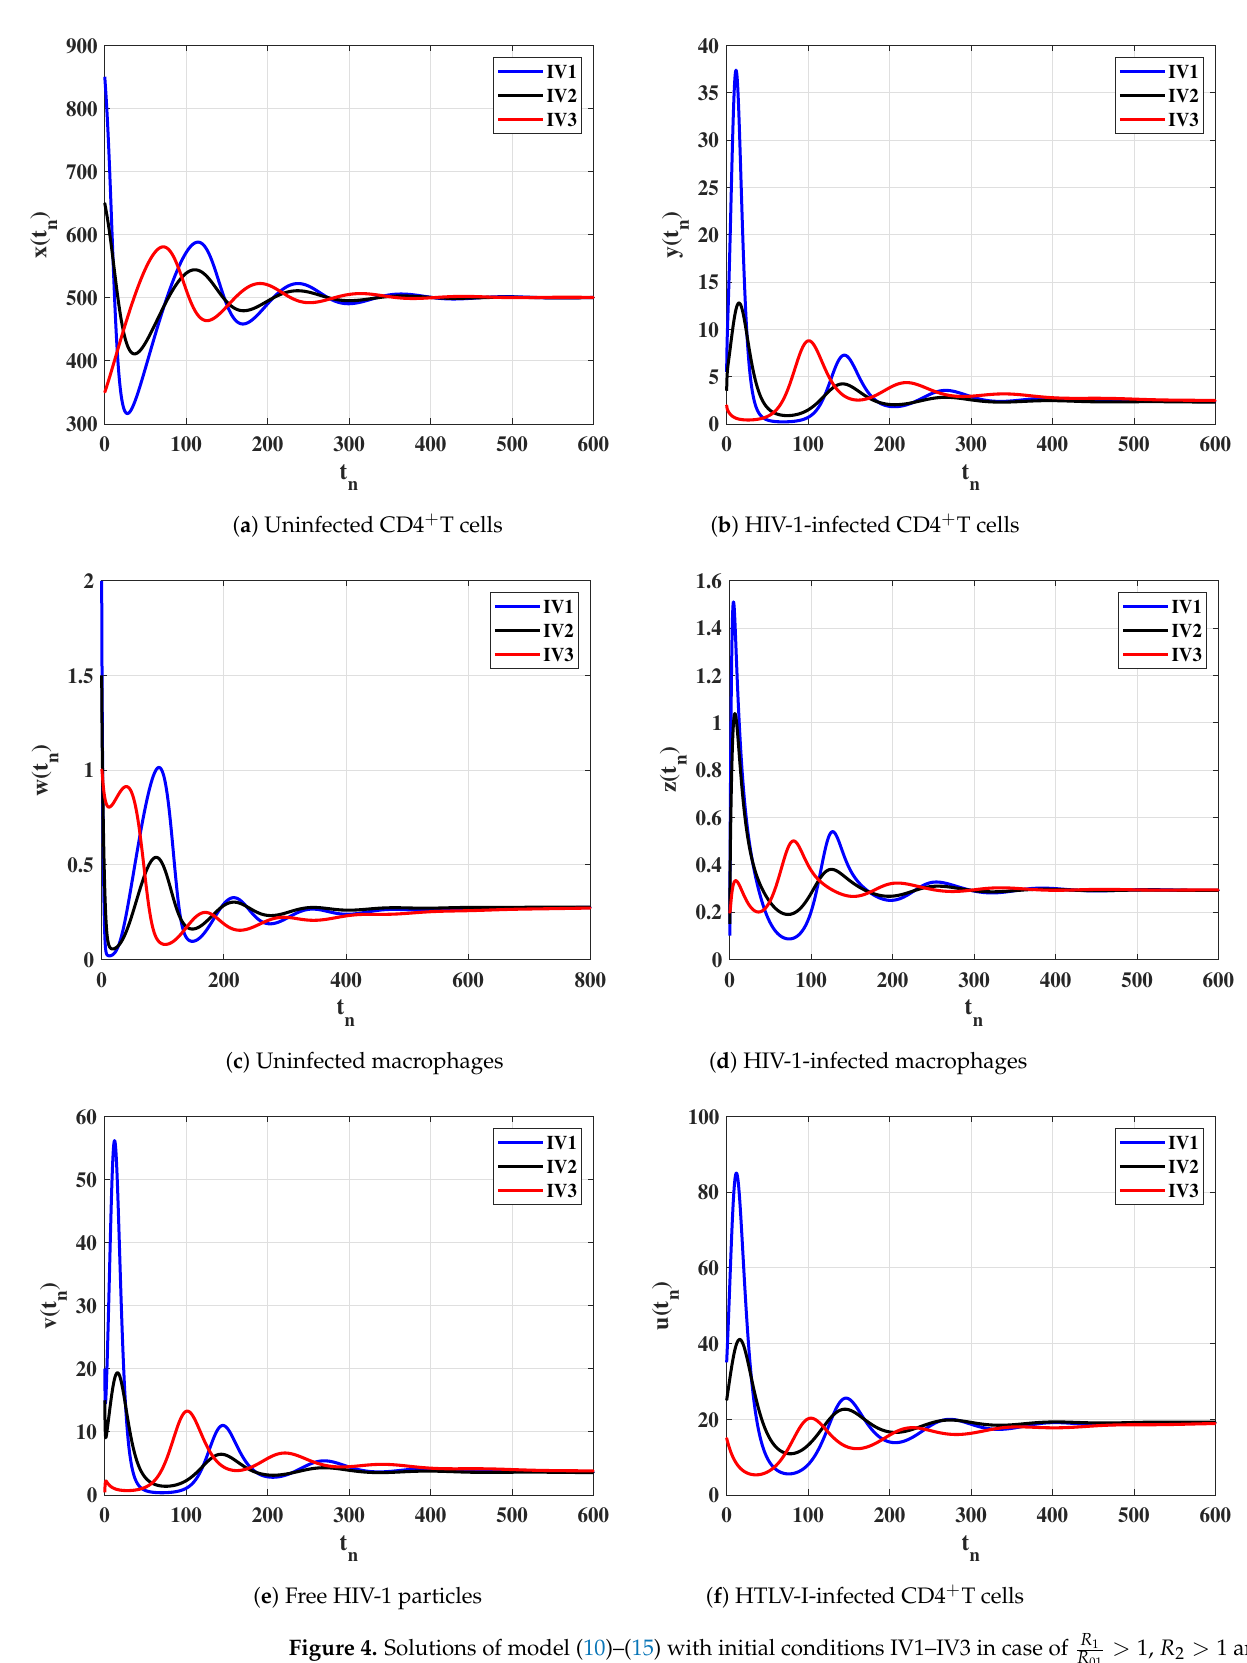
Figure 4. Solutions of model (10)–(15) with initial conditions IV1–IV3 in case of R 1 R 3 >